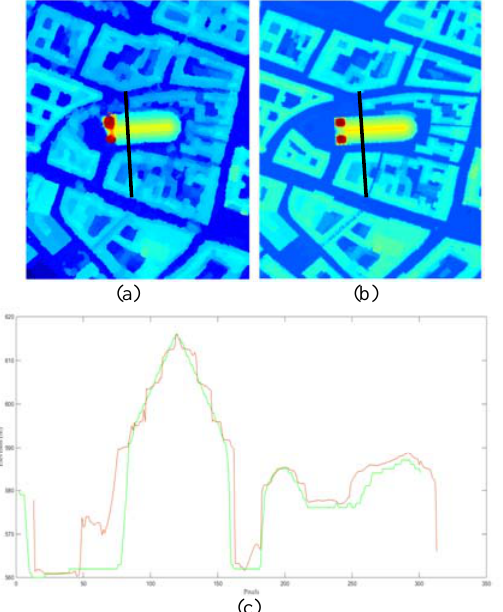
Figure 1. Comparison for profiles of buildings in two datasets: (a) WorldView-2-DSM, (b) LiDAR-DSM and (c) elevation profiles reconstructed from imagery (red) and LiDAR